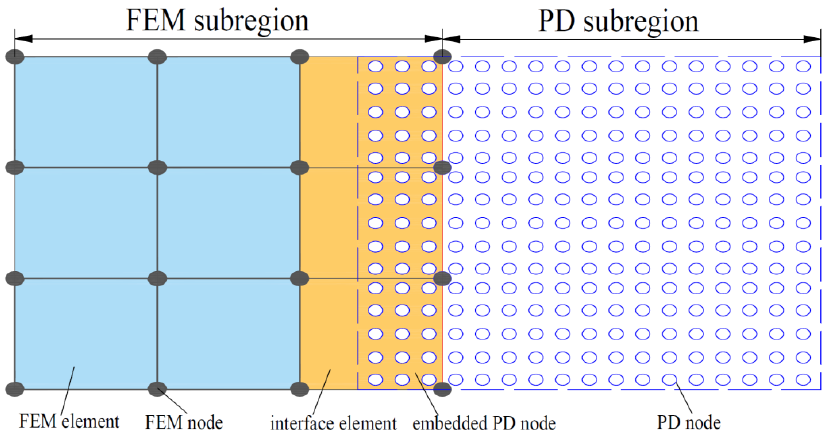
Figure 1. PD-FEM coupling scheme.